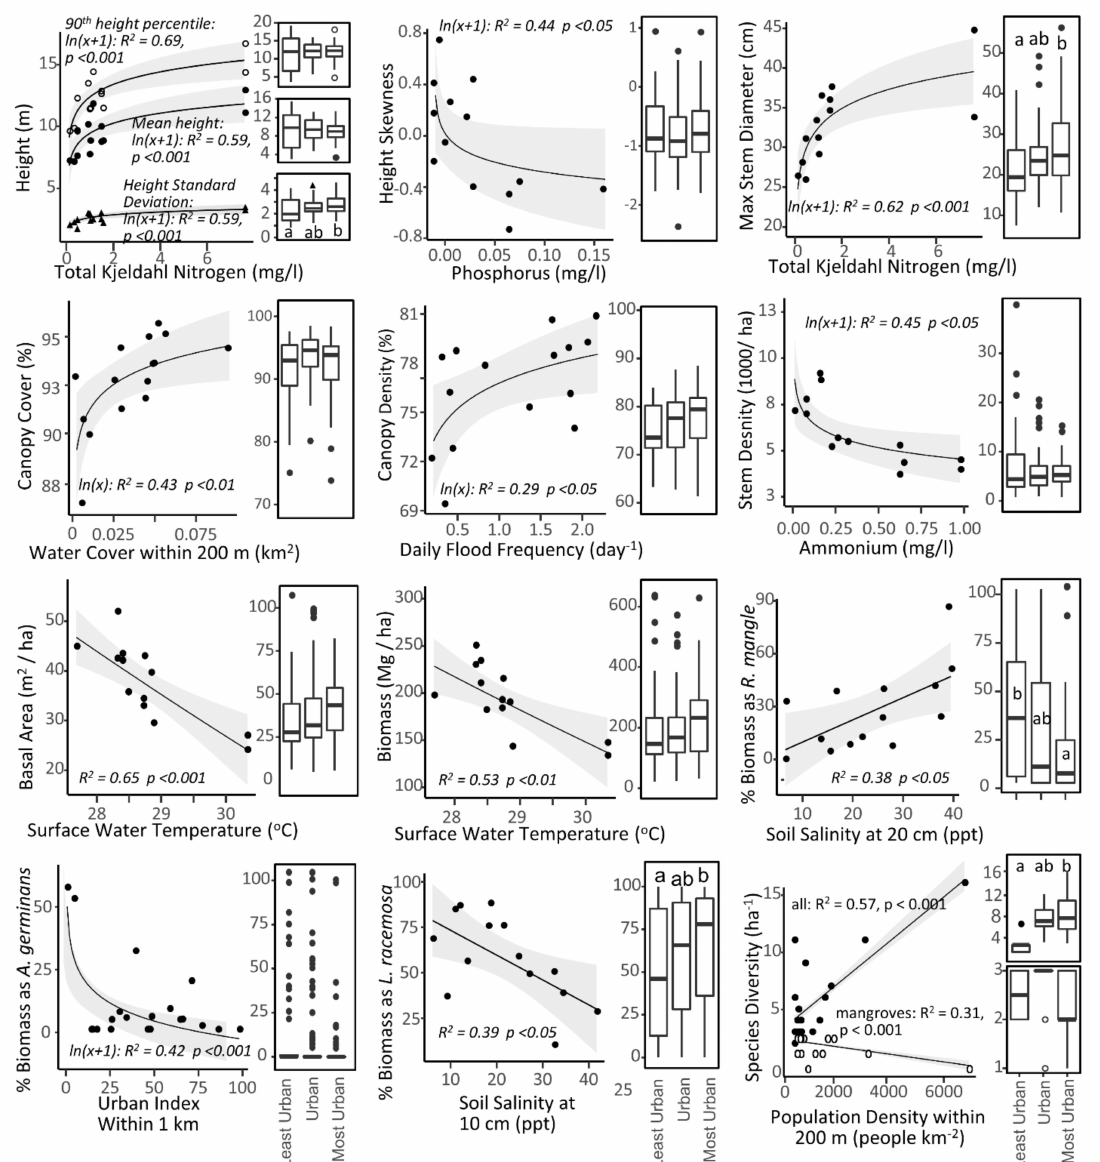
Figure 5. Mean site forest structure and composition measurements with their strongest predictor variables from the analysis, accompanied by boxplots of least urban, urban, and most urban plots. Letters above boxes denote statistical di ff erences. In tree height as a response to total Kjeldahl Nitrogen (top left), open circles, filled circles, and triangles correspond to: 90th height percentile, mean height and SD of height, respectively. In species density as a response to population density (bottom right), open circles and filled circles denote overall tree species and true mangrove species, respectively. Flooding dynamics, surface water nitrogen concentrations, porewater salinity, and surrounding land cover are all strong predictors of individual forest structure and composition metrics. Shaded areas are 95% confidence